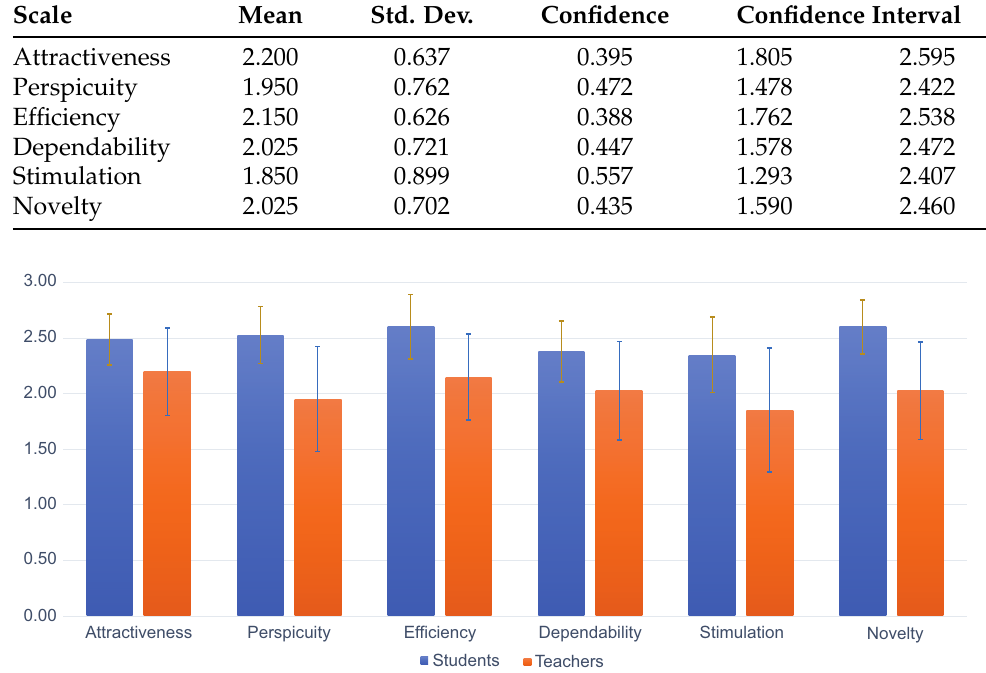
Figure 8. Scales results.